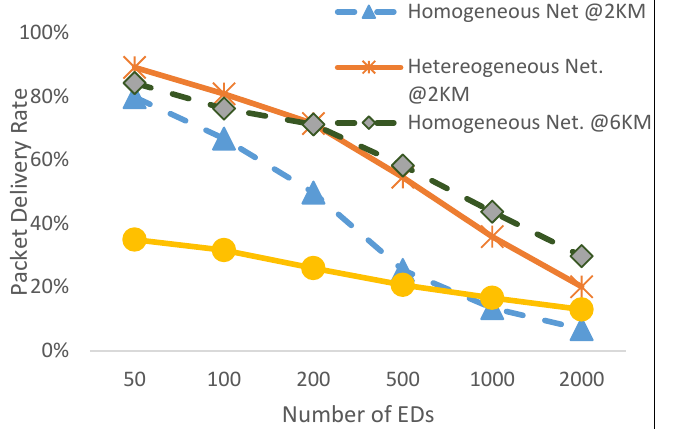
Figure 7: LoRaWAN PDR with varying number of EDs.